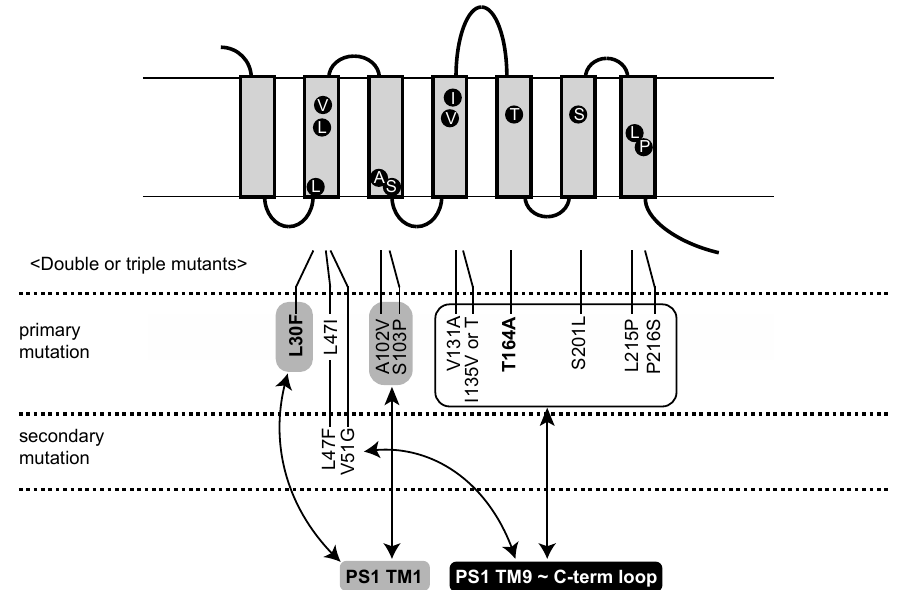
Figure 1. Aph1 mutants active in the absence of NCT map to transmembrane domains. Mutations in double or single mutants are indicated in the model with the seven transmembrane domains (TMDs) of Aph1. Mutations active as single mutants are shown as primary mutations; mutations active only in combination are shown as secondary mutations. The Aph1 mutations are in close proximity to PS1 TMD1 or TMD9 connected to the C-terminal loop, as indicated by arrows. L30F/T164A mutations, which activated γ -secretase, are shown in bold. Table 1. Screening for Aph1 mutants active without NCT. The growth of cells with APP-Gal4, PS1 (WT or S438P), and Pen2 were analyzed on SD-LWHUAde medium after 3 days at 30 °C. “+++” represent full growth, cells formed colonies (>1 mm); “++” represent partial growth with colonies (>0.5 mm); and “-” represent no growth. 1.1 × 10 6 Cells were screened.